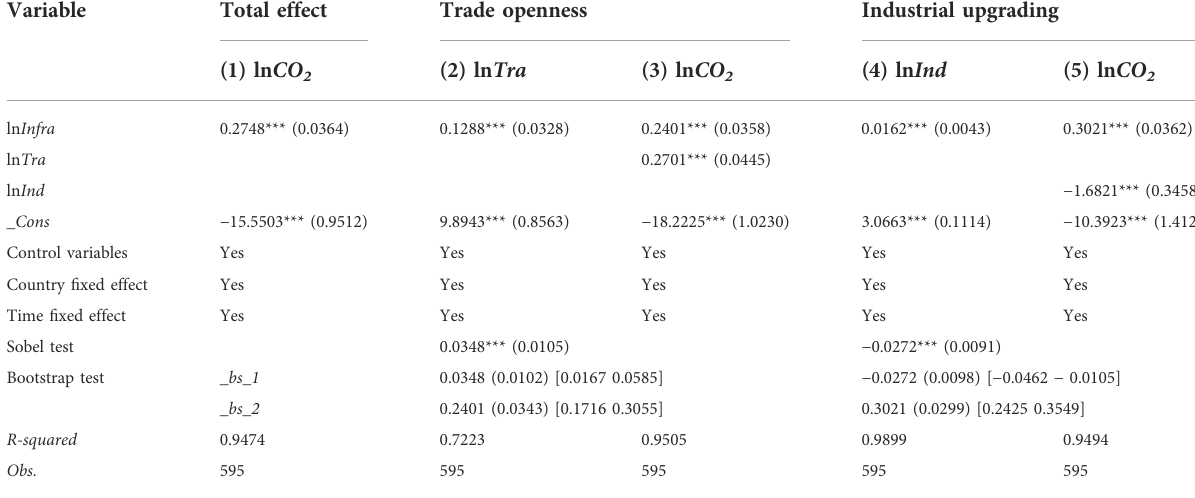
TABLE 9 Results of mediation effect